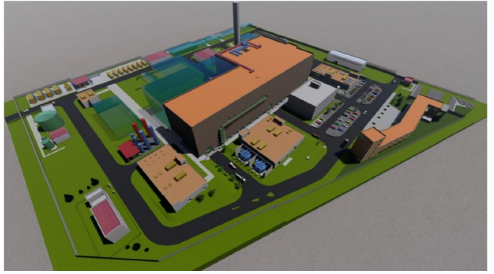
Figure 23. Recreation of the installation in its proposed location. Reprinted from Ref.